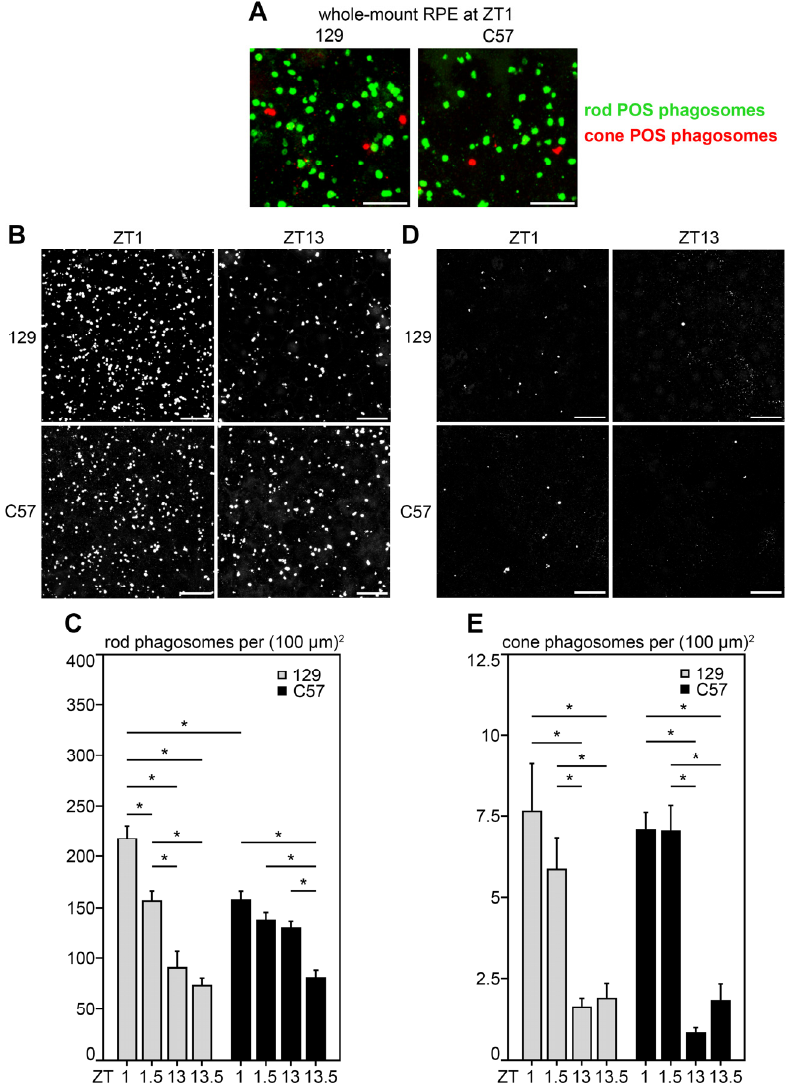
Figure 1. Differences in diurnal rod but not cone POS phagosome content in RPE of 129 and C57 mice: accentuated rod POS phagosome peak at ZT1 but no peak after dark in 129 RPE. RPE